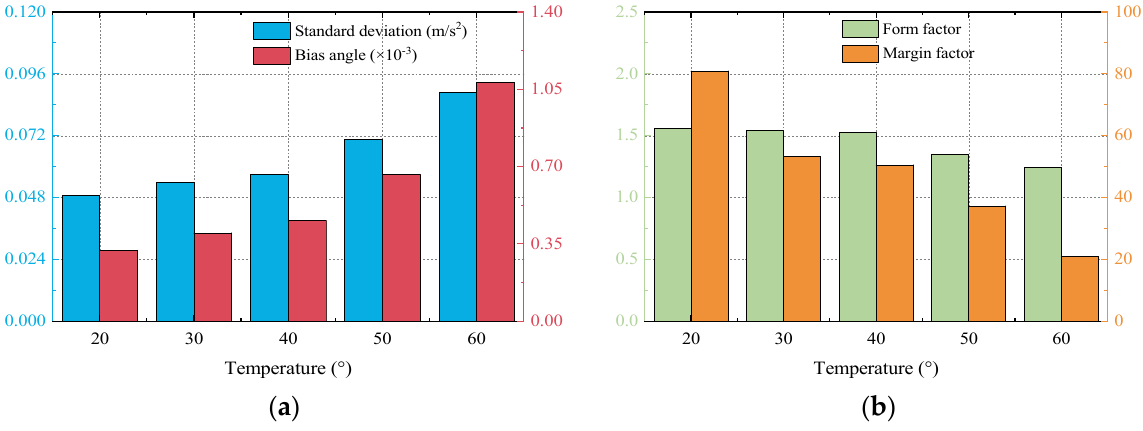
Figure 18. Effect of temperature on time domain eigenvalues. ( a ) Standard deviation and bias angle, ( b ) form factor and margin factor.